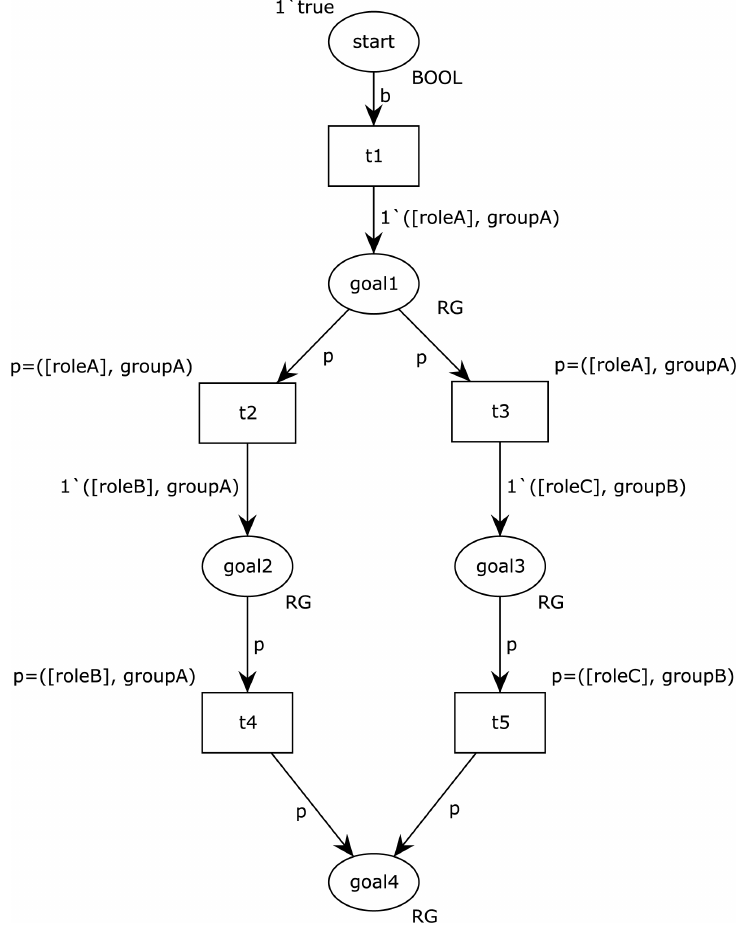
Figure 7. Example of a CPN with all elements of CPN4M